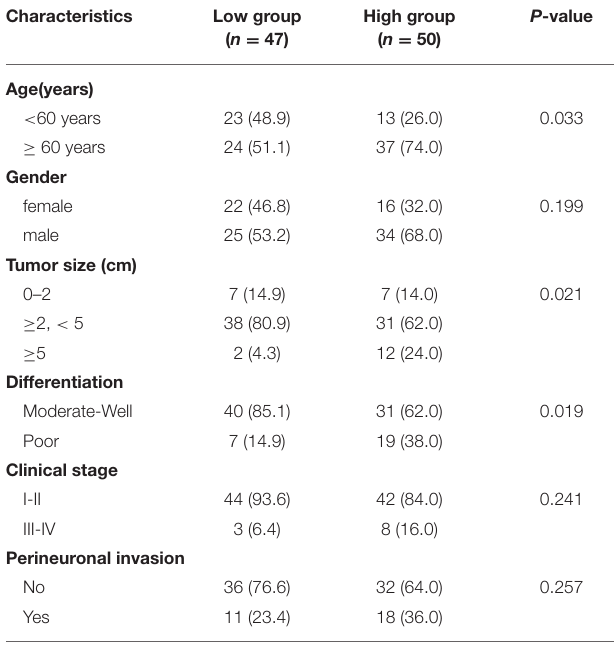
TABLE 1 | Clinical characteristics of pancreatic cancer stratified with TMPRSS4